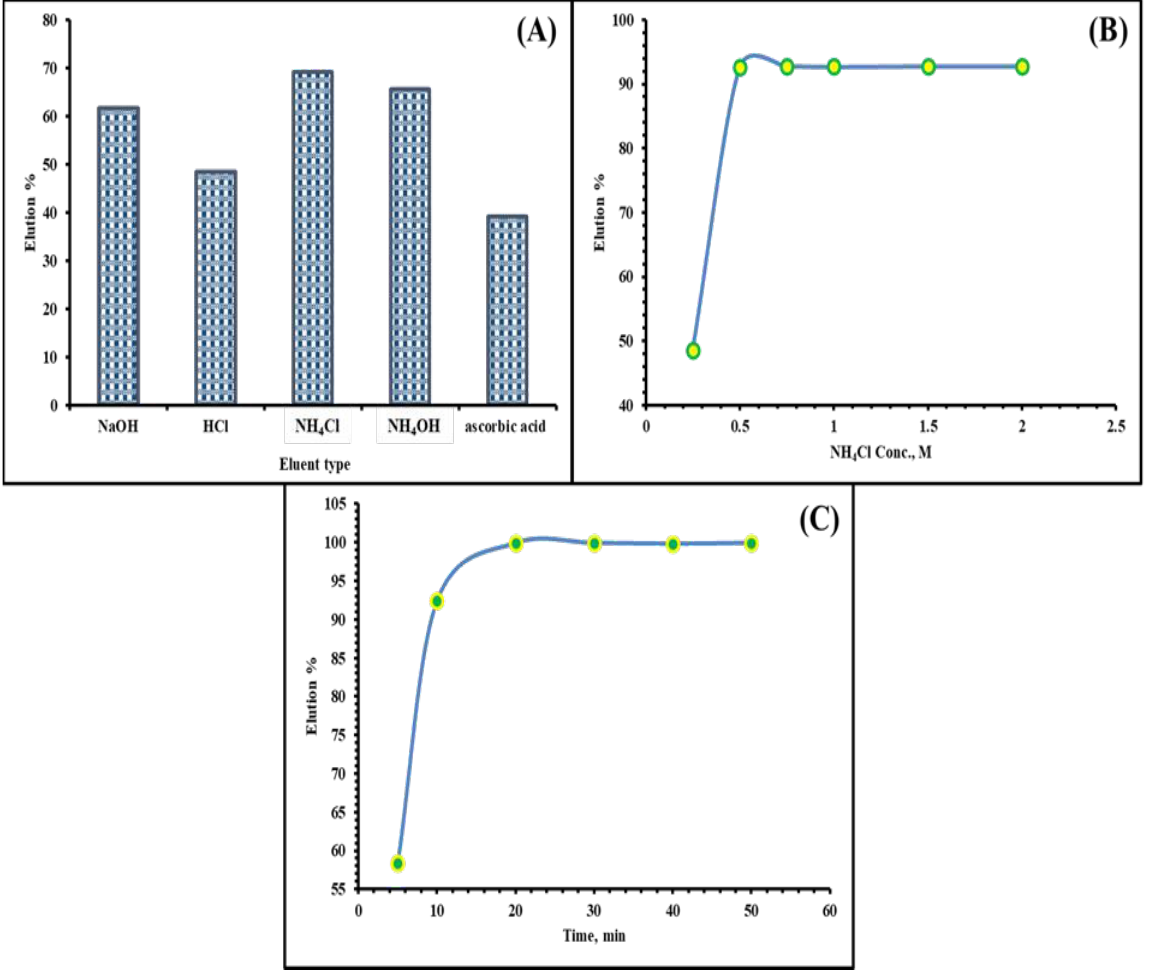
Figure 16. Factors affecting the desorption of W(VI) from HNAP/QA: ( A ) eluent type, ( B ) eluent concentration, and ( C ) elution time.